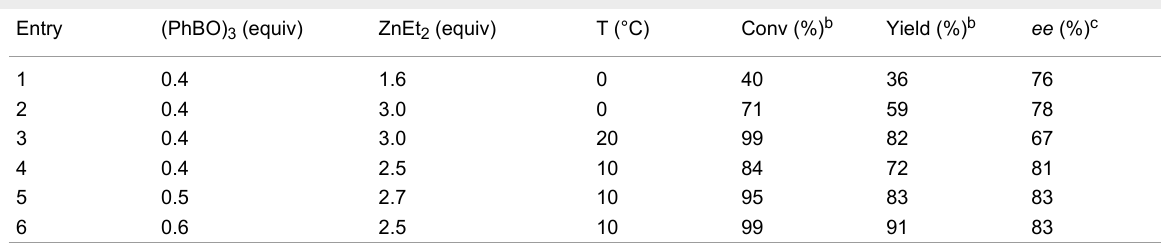
Table 2: Optimization of the reaction conditions for the continuous flow process.